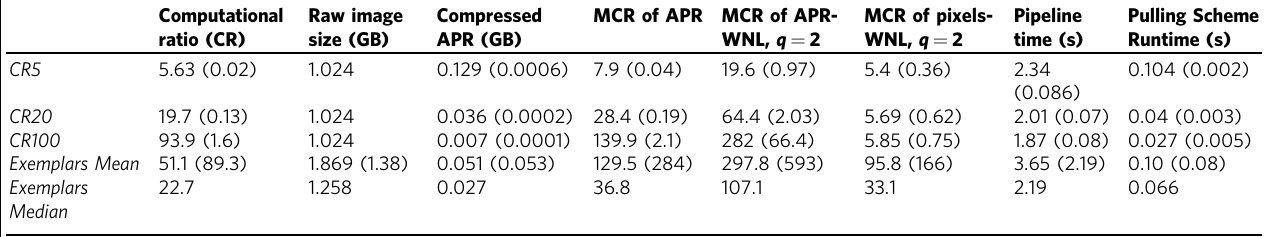
Results are shown for synthetic images with fi xed CR = 5,20,100 and for 19 real-world exemplar datasets (see Supplementary Table 3). For the exemplars, we report the means, standard deviations (brackets),andmediansofthevalues overallexemplarimages.For thesynthetic fi xed-CRbenchmarks,the effectiveCRandthe MemoryCompressionRatios(MCR)areaveragedoverimagesizesfrom 200 3 to 800 3 (standard deviations in brackets) and the values for absolute runtimes and storage requirements are given for images of size 800 3 . For comparison, we also report the MCR using lossy within-noise-level (WNL) compression 30 of both the APR and the pixel images for the same compression parameter value ( q = 2, see Supplementary Note 20). We also show the time taken to transform the images to the APR on the benchmark machine and the runtime of the Pulling Scheme